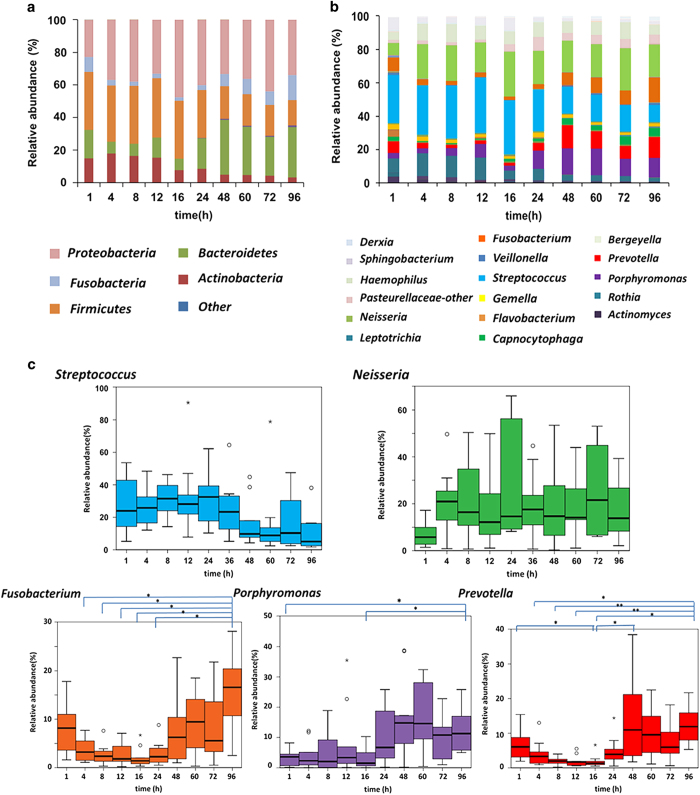
Relative abundances of bacterial taxa among the subjects. (a) Relative abundance of bacterial phyla in all subjects (n=10). This graph represents the average of data collected from all the subjects at each time point. (b) Proportional abundance of genera in all the subjects (n=10). The temporal changes in the relative amounts of each genus are indicated. The most frequently detected taxa (>1% relative abundance) in each level are shown. (c) Proportional abundance of five genera. Boxes extend from the 25th to 75th percentiles. Circles represent outliers. Asterisks above the whisker indicate a statistically significant difference at each time. *P<0.05; **P<0.01 (Kruskal–Wallis, Steel–Dwass test).